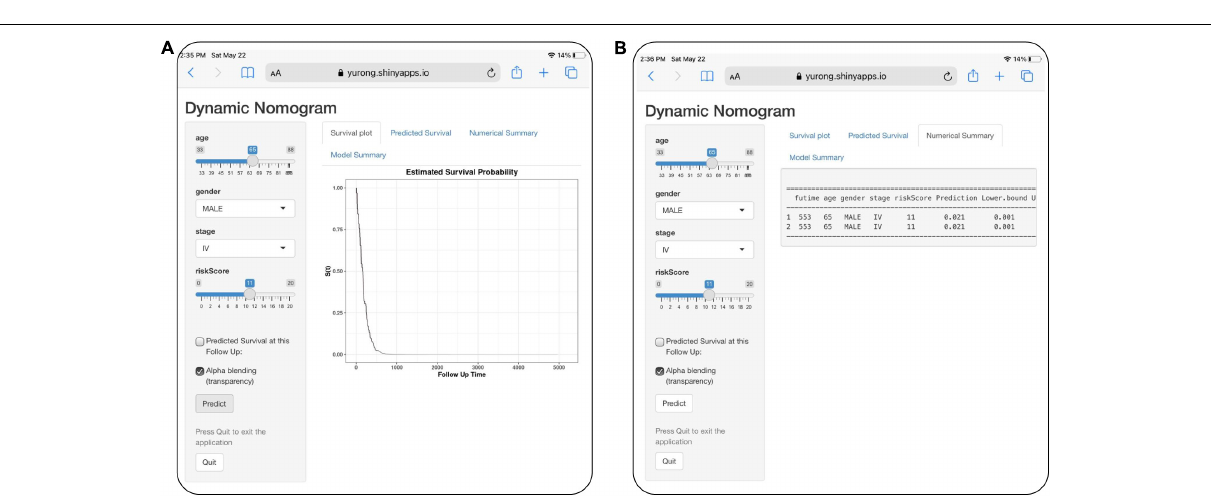
Frontiers in Cell and Developmental Biology |